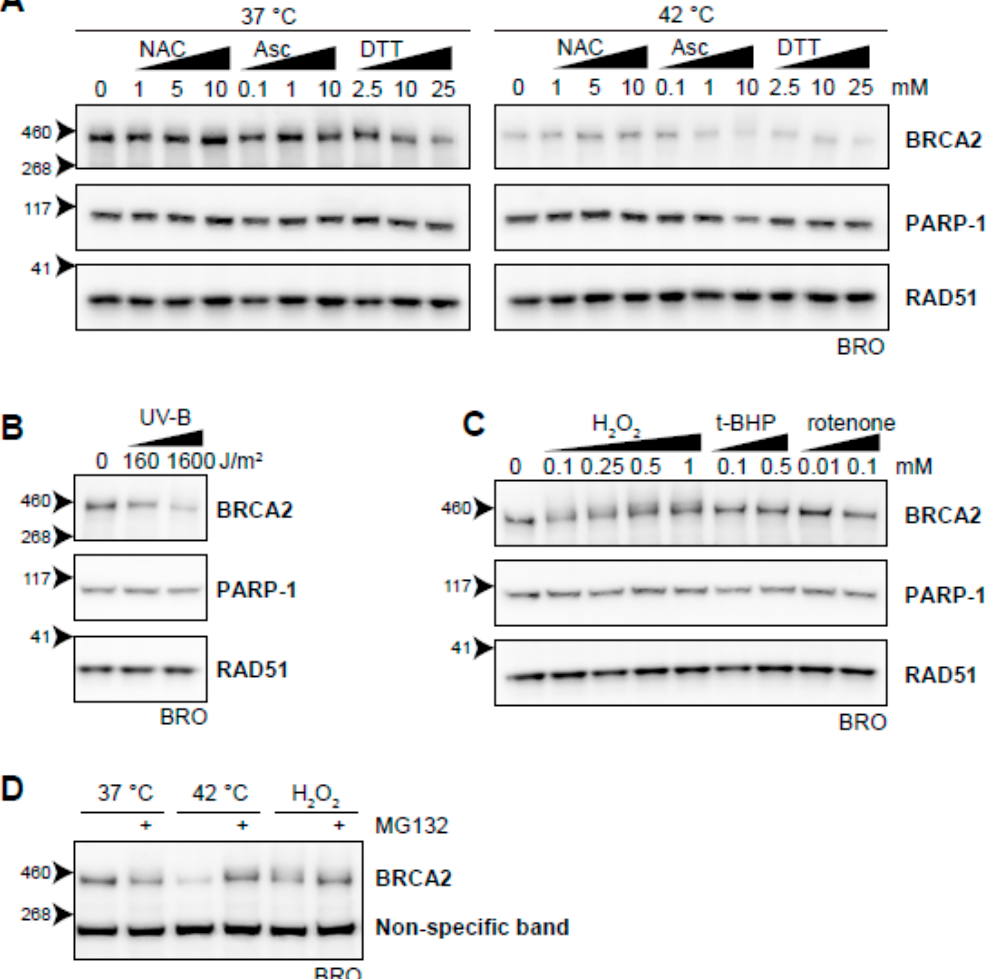
Figure 7. Oxidative stress as an inducer of BRCA2 degradation. (A ) BRCA2 levels in BRO cells subjected to hyperthermia in the presence of indicated doses of antioxidant compounds N-acetylcysteine (NAC), ascorbic Acid (Asc), or dithiothreitol (DTT). ( B ) BRCA2 levels in BRO cells subjected to the indicated dose of ultraviolet-B and lysed three hours afterwards. ( C ) BRCA2 levels in BRO cells treated with various concentrations of oxidative stress-inducers H 2 O 2 , tert-Butyl hydroperoxide (t-BHP), and Rotenone. ( D ) BRCA2 levels in BRO cells exposed to hyperthermia or H 2 O 2 (0.1 mM) in the presence or absence of proteasome inhibitor MG132 (50 µM).